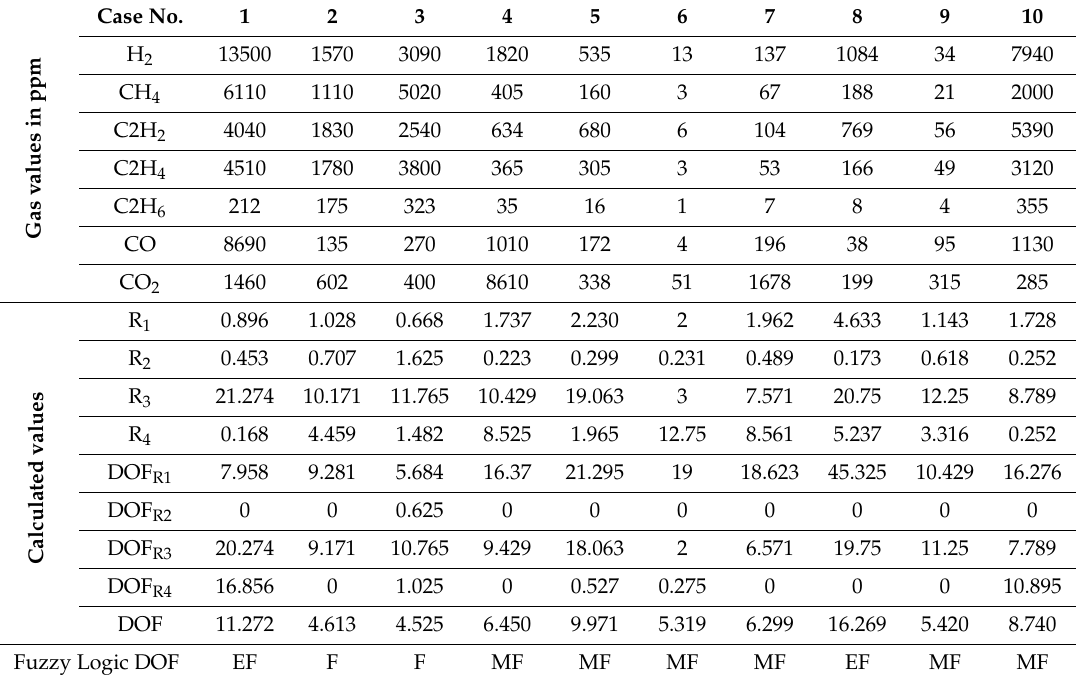
Table 6. Typical DOF calculated for 10 cases of EDHE